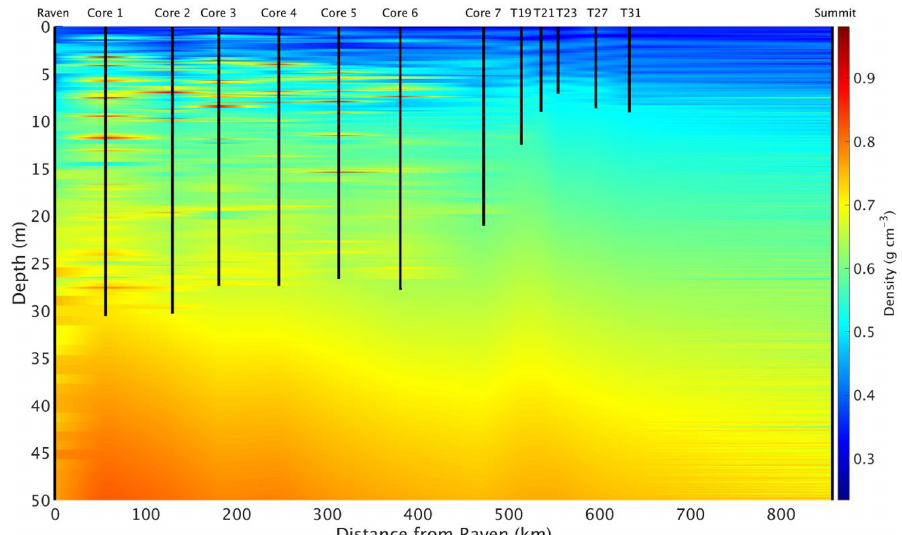
Figure 4. Depth–density profile along the main 2016 traverse used for calculation of electromagnetic wave velocity and accumulation rates in this study. Densities are linearly interpolated between the two nearest cores and are modeled using Herron–Langway profiles below the depth of each core. The left and right boundary data come from the Raven–Dye-2 and Summit firn cores, respectively. Ice layers in Cores 1–5 are clearly visible as red lenses, but their extent is, in reality, likely more